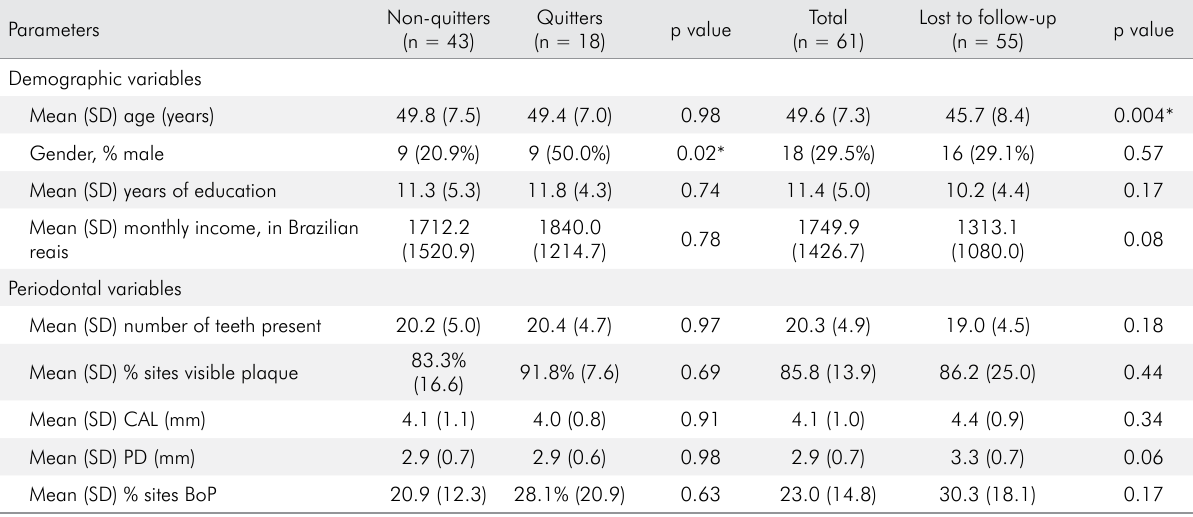
Table 1. Baseline demographic and periodontal clinical characteristics of non-quitters (smokers and oscillators combined) (n = 43), quitters (n = 18) and subjects lost after 24 months of follow-up (n = 55).